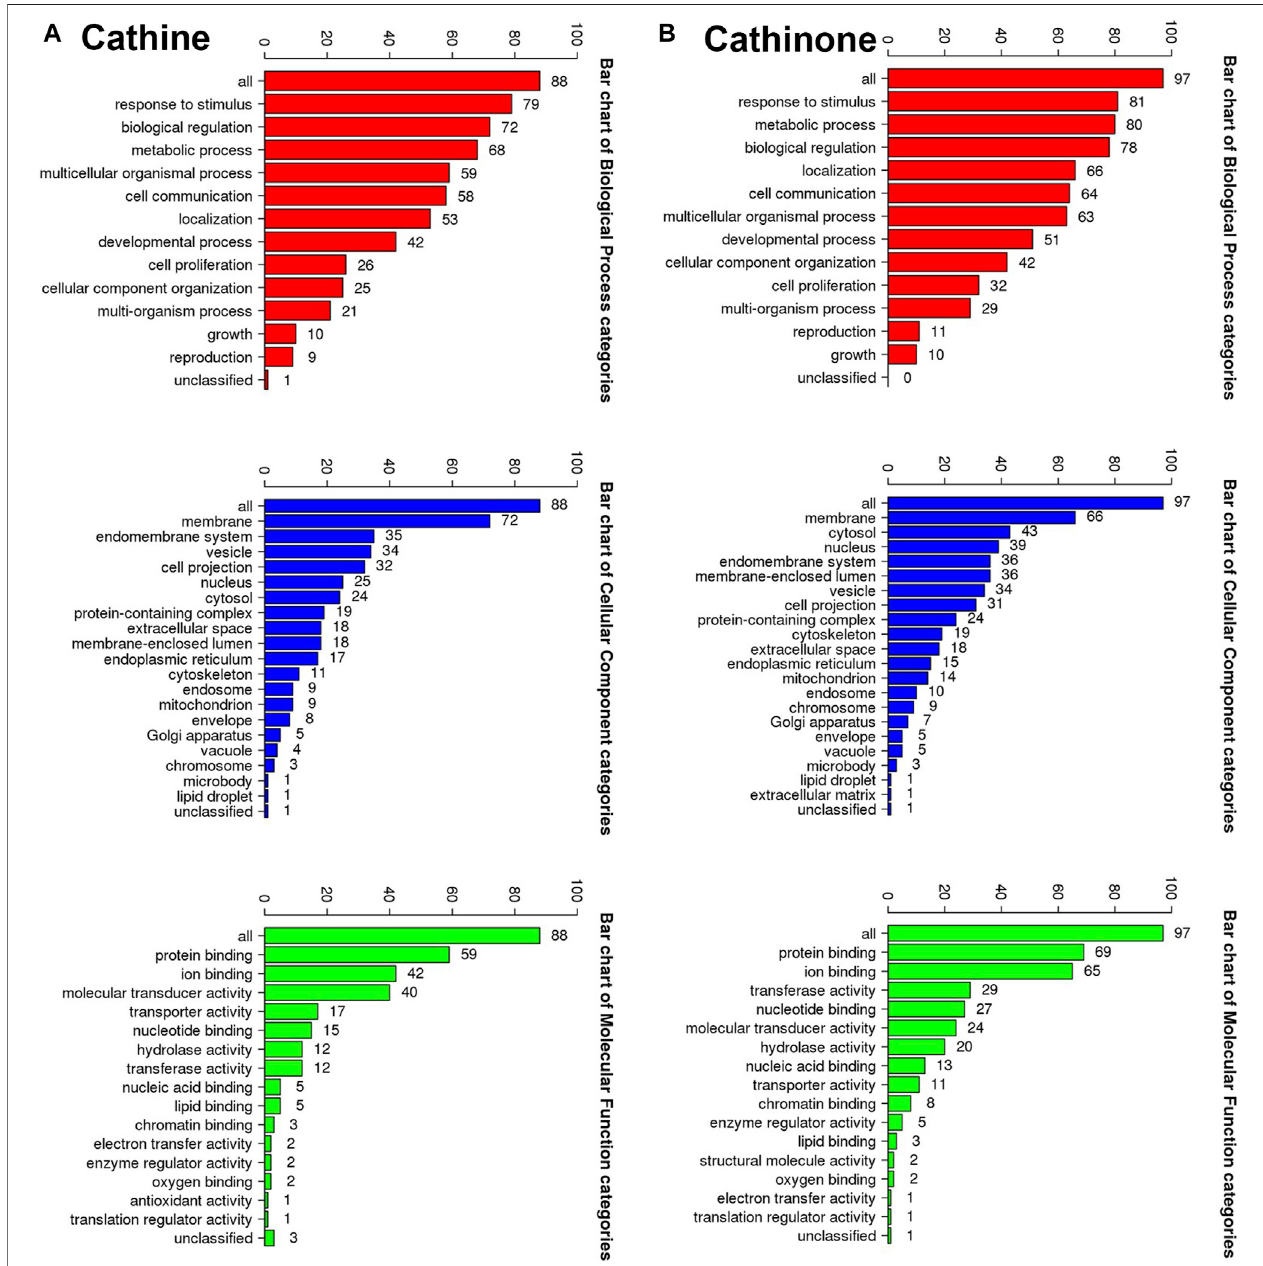
FIGURE 9 | The GO Slim analysis. The summaries are based upon the 88 and 97 unique Entrez gene IDs for the putative protein targets of cathine (A) and cathinone (B) ,respectively. Potential effects onthe biologicalprocess (bars inred), cellular component(barsinblue) and molecular function(bars ingreen). The heightof each bar characterizes the number of IDs in the user list and in the